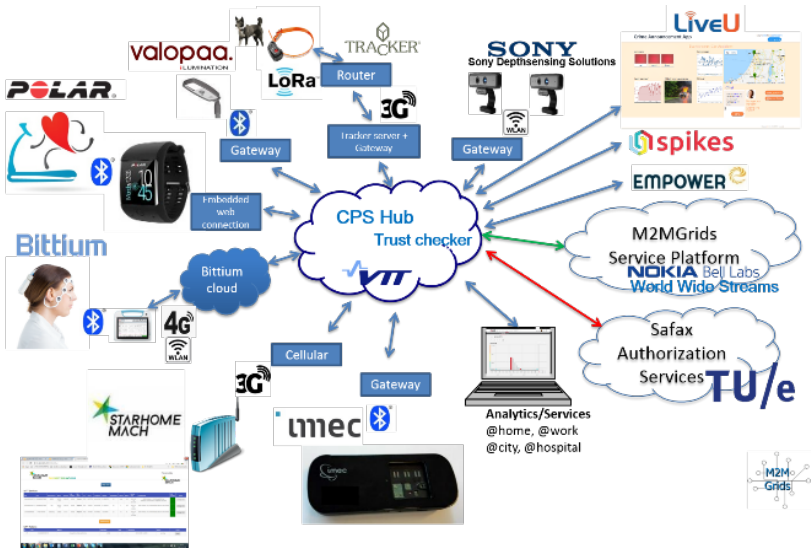
Figure 27. Structure of the smart mobility in the emergency